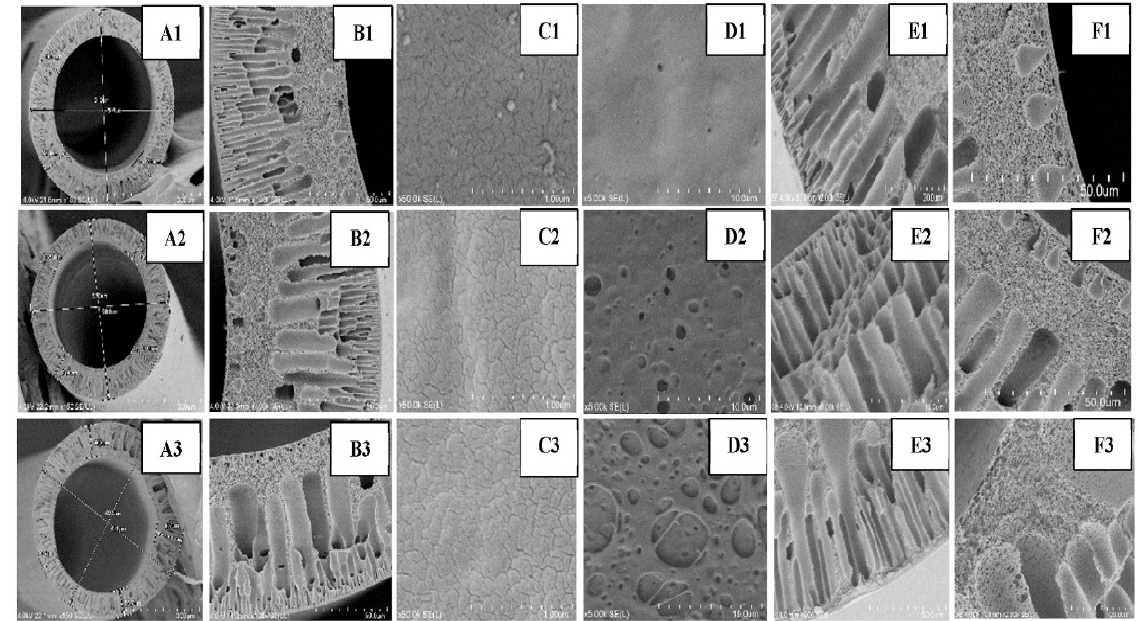
Figure 2. The FESEM images of polyamide imide-sulfonated poly (ether ether keton) (PAI-SPEEK) membranes: (1) 100/0; (2) 95/5; (3) 85/15; ( A ) cross-section; ( B ) outer-surface; ( C ) inner-surface; ( D ) outer layer; ( E ) inner layer; (F) inner sponge-like layer. Reprinted with permission from ref. [34]. © 2020 Elsevier Ltd.